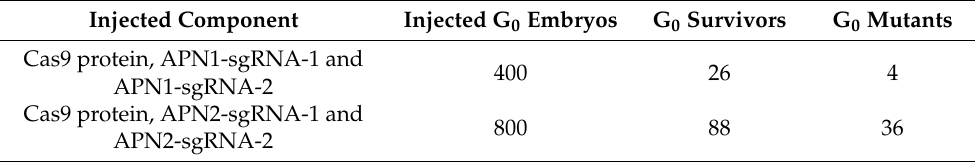
Table 2. Transformation data of G 0 embryos injected with CRISPR/Cas9